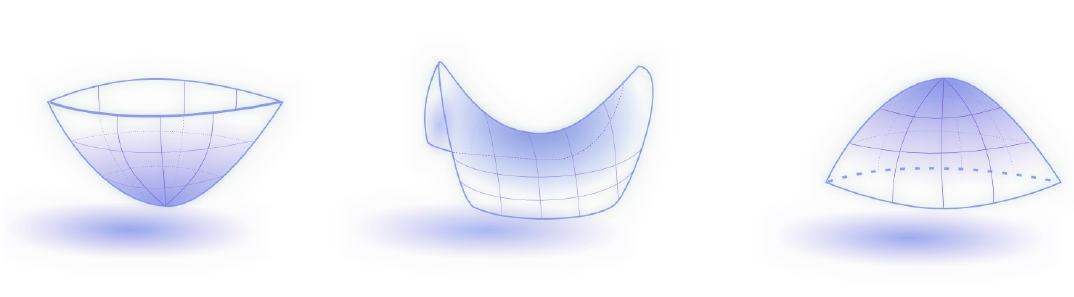
Figure 1. Minimum, Saddle, and Maximum,